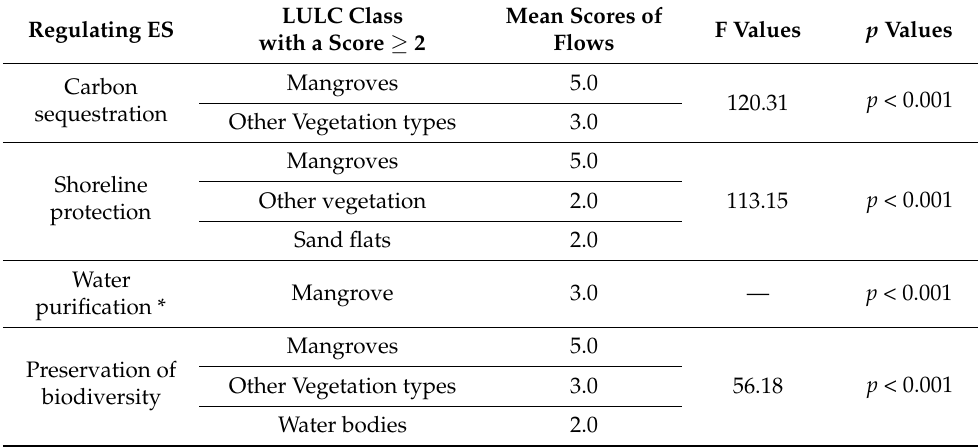
Table 4. Summary statistics of the one-way ANOVA-test for the assessment of flow regulating ES from the LULC with high scores: n = 80 for Ungwana bay, Kenya.